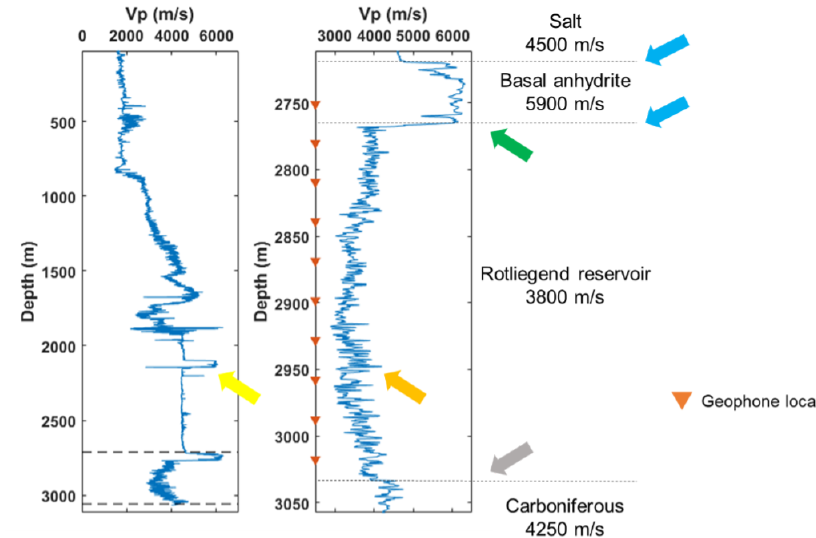
Figure 5. SDM-1 compressional velocities ( Vp ). Left : Overall Vp log. Right : Local Vp log around the depth interval of interest.